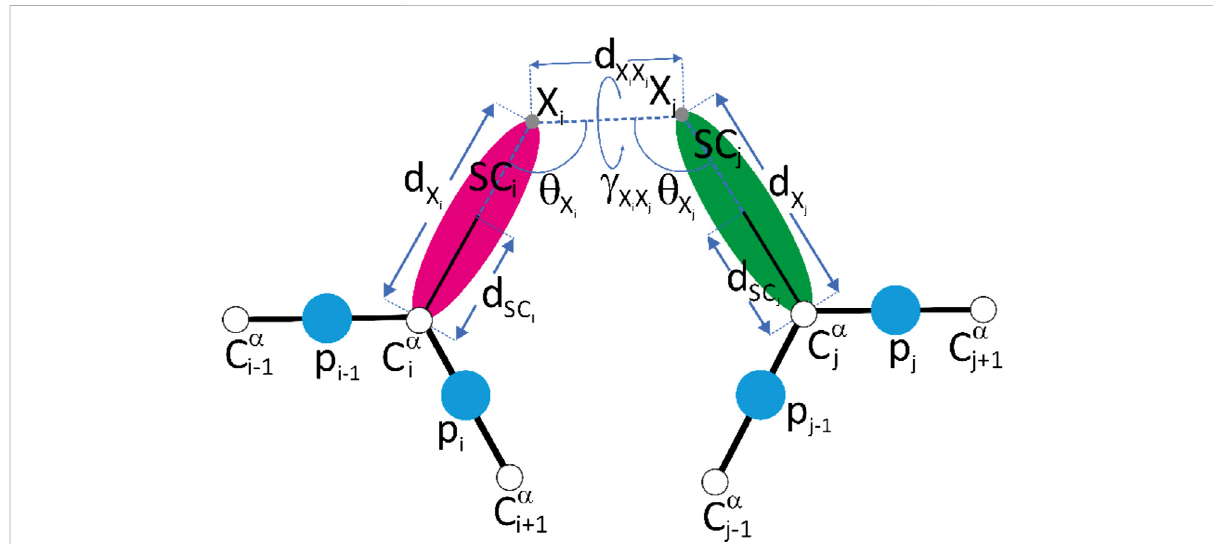
FIGURE 2 Ascheme oftherepresentationofcrosslinkrestraintsbetweenresidueswith indices i and j ,respectively, intheUNRESmodel. TheC α atoms are shown as white spheres, the united side chains (SC) are shown as colored spheroids, and the united peptide groups (p) are shown as blue spheres. The crosslinkable side chains (aspartic acid, glutamic acid or lysine) are linked with adipic/pimelic acid (ADH or PDH) dihydrazide or by the glutaric/ suberic acid(BS 2 GorBS 3 ),respectively. The linkisanchoredin(approximately)thepositions oftheside-chaincarbonyl-carbonatoms ofAspor Glu (for the ADH or PDH crosslinks) or in the positions of the lysine side-chain nitrogen atoms (for the BS 2 G or BS 3 crosslinks), respectively. The anchorpoints(indicatedwith “ X ” andlight-grayspheres)arelocatedontheC α / SCaxesoftheUNRESresidues.Thegeometricparametersonwhich the respective pseudopotentials depend [Eqs 11 – 14] are also shown in the Figure. Reproduced with permission from Kogut et al. (2021), J. Comput. Chem. 42, 2054 (2021). Copyright 2021 John Wiley and